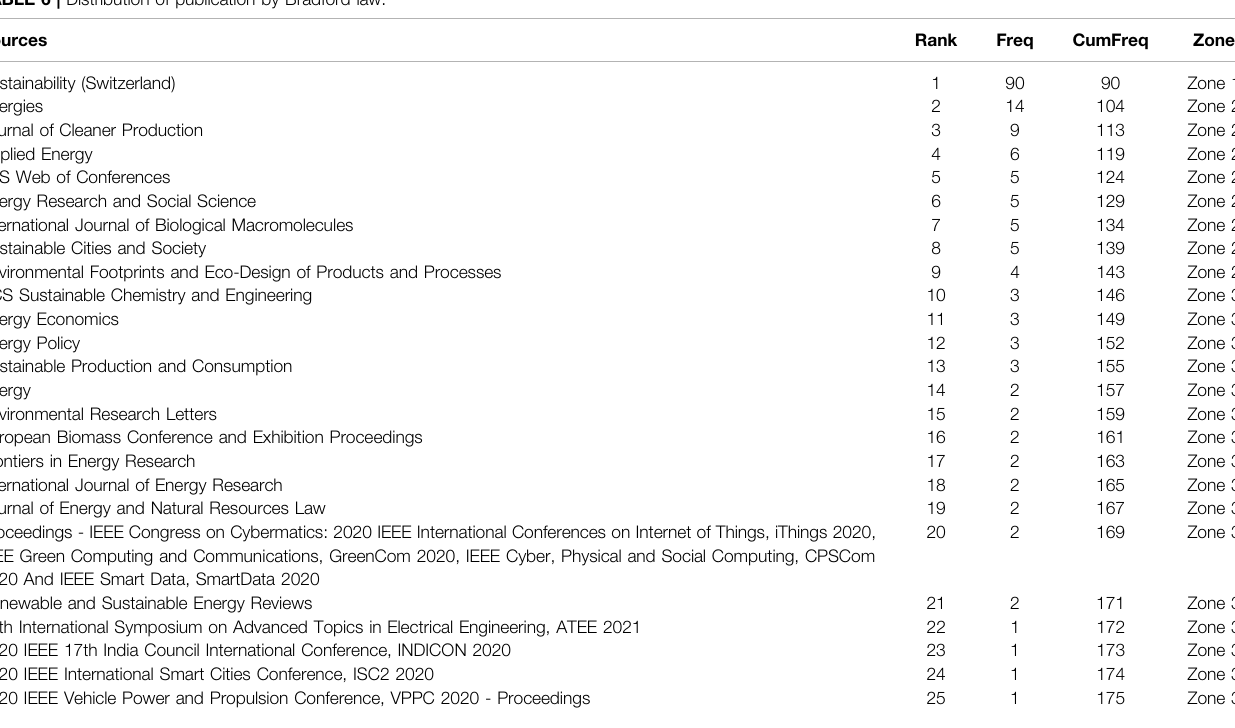
TABLE 6 | Distribution of publication by Bradford law.